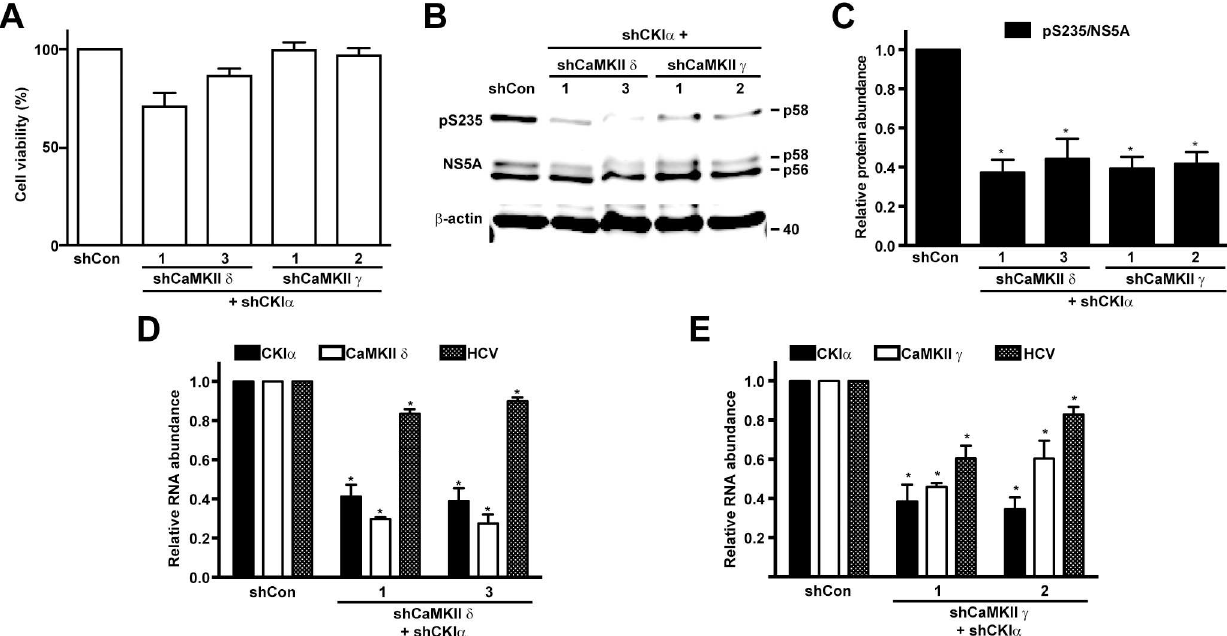
Fig 7. CKI α plus CaMKII double knockdown reduced NS5A S235 phosphorylation and HCV RNA levels in the infected Huh7.5.1 cells. (A) Viability of the Huh7.5.1cells with CKI α plus CaMKII doubleknockdown. (B) Representative and summary (C) of the immunoblotting for NS5A and NS5A phosphorylation at S235 (pS235)in the HCV-infected Huh7.5.1cells with or without CKI α plus CaMKII doubleknockdown. One day after the cells were infected with HCV (J6/JFH1), the cells were subjectedto shRNA-baseddoubleknockdownfor 6 days prior to the immunoblotting analysis. Values are Mean ± SEM (n = 3). Asterisk indicatessignificancei.e. p < 0.05,t-test against the values in the non- targeted control cells (shCon). Protein abundance was quantifiedwith the Li-Corscanner, adjustedfor the loadings(i.e. against β -actin) and normalized with the values in the control cells. (D and E) Quantitative measurements of kinase mRNA and HCV RNA in the HCV-infected Huh7.5.1cells with or without CKI α plus CaMKII doubleknockdown. The experiments were done as those in b except that RNA was collected for the analysis. The GAPDH mRNA levels were analyzedas loadingcontrols. RelativeRNA abundance was normalizedto the values of the control cells.